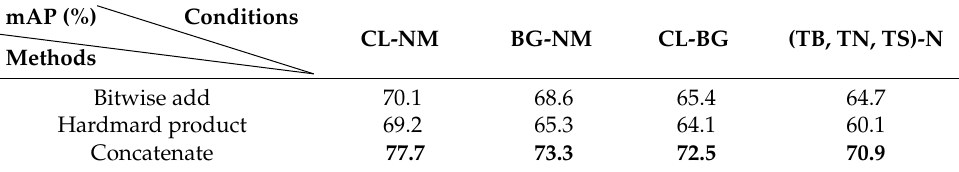
Table 3. Comparison among the three fusion methods on the cross condition and long-term condition of the testing set. mAP (%) is